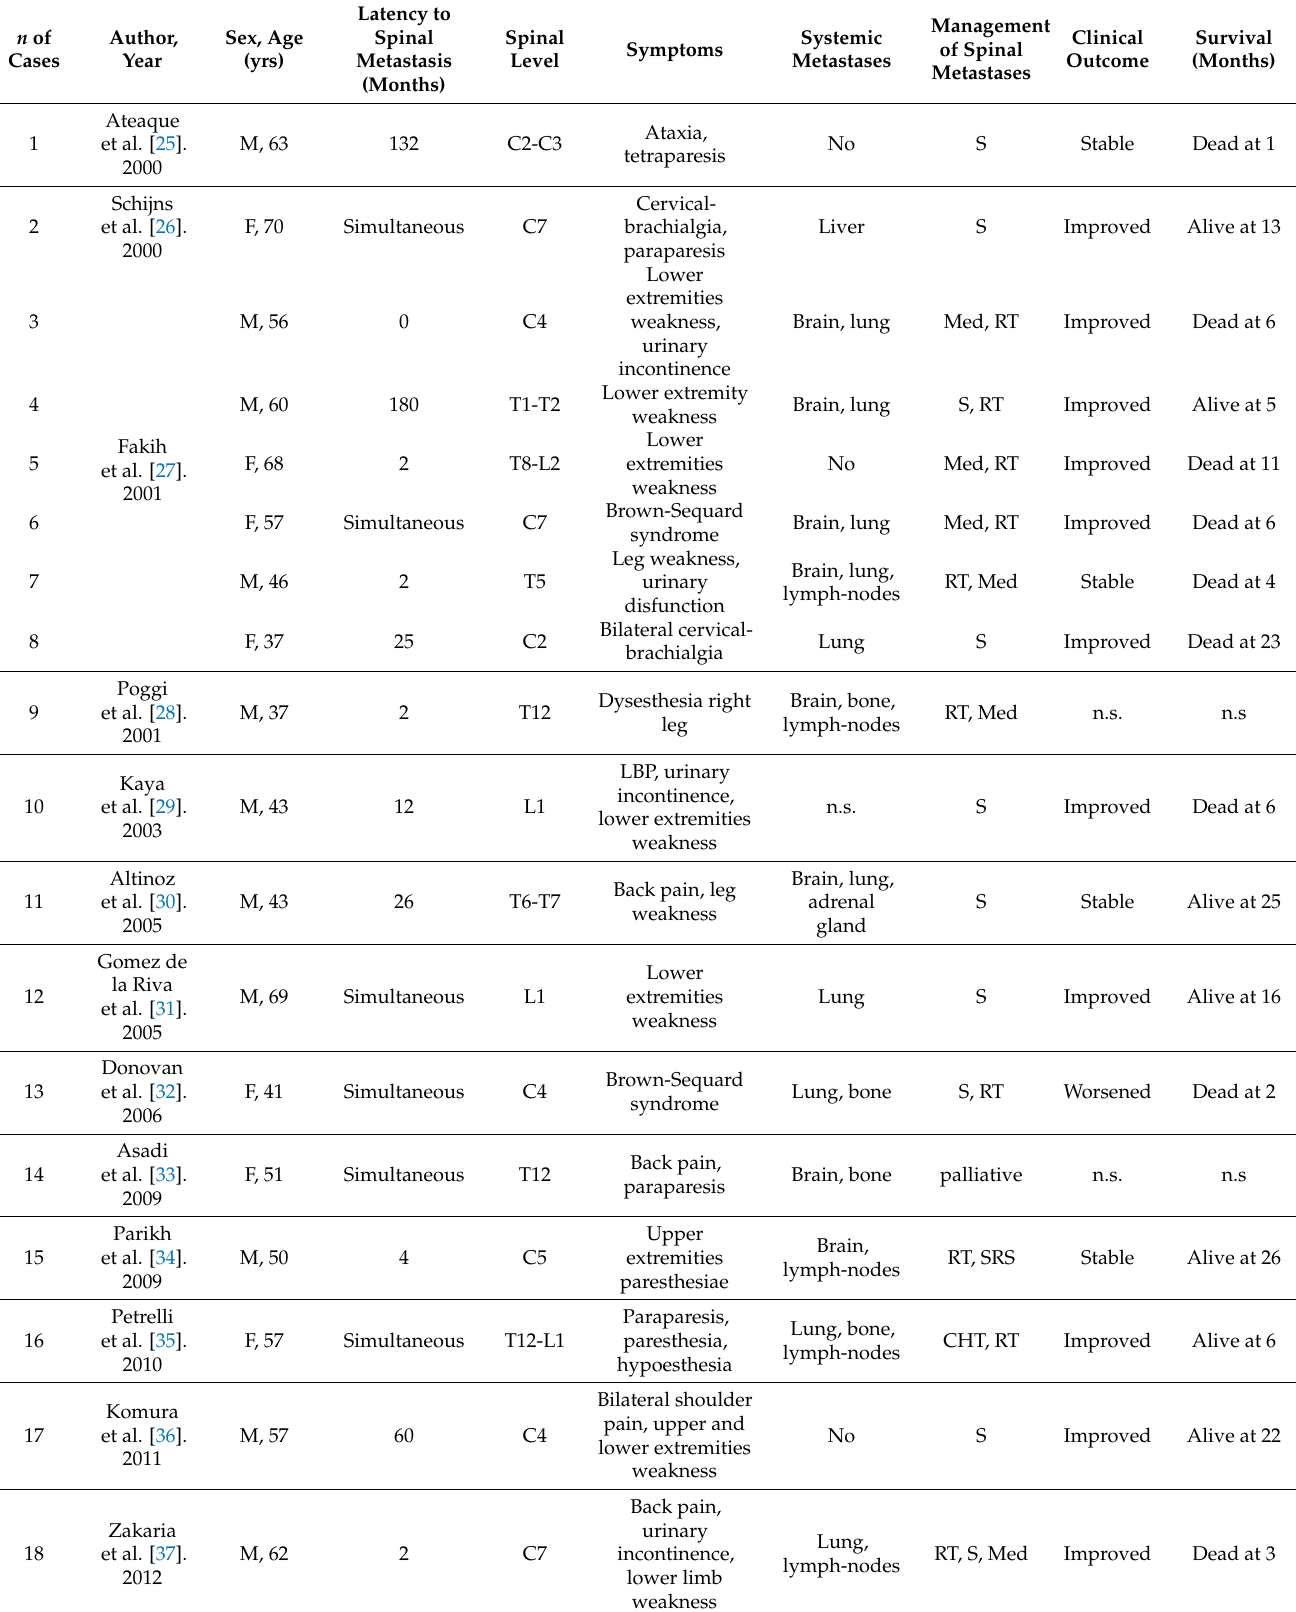
Table 3. Reported cases of intramedullary spinal cord metastasis from renal cell